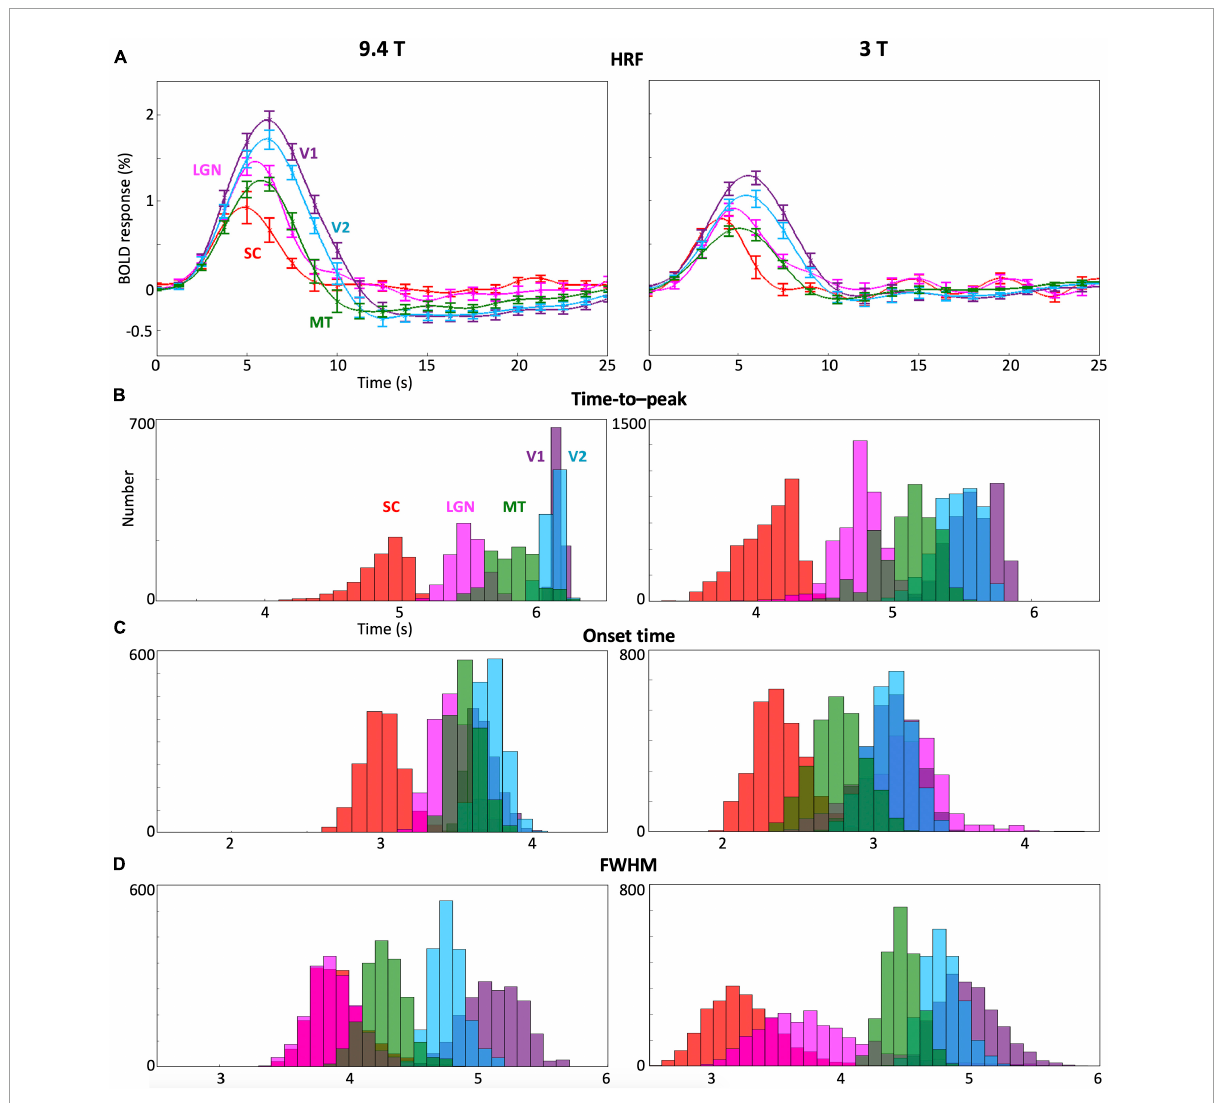
FIGURE4 (A) Mean and 68% confidence intervals of the HRF across subjects for each ROI at 9.4T and 3T. (B–D) Bootstrapped histograms of the temporal HRF parameters across subjects in each